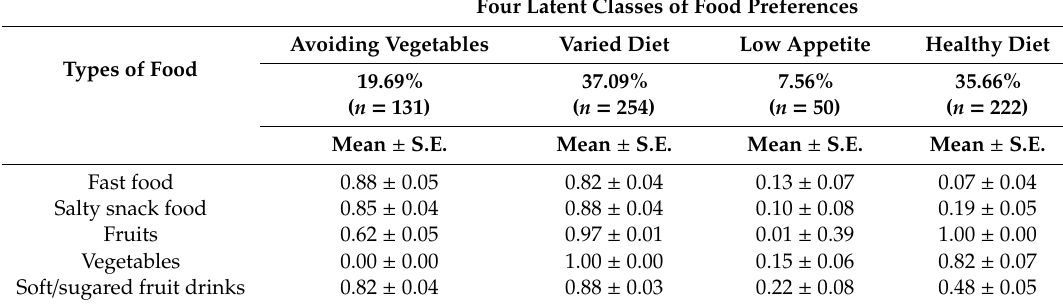
Figure 1. Description of the patterns of food preferences. x -axis = indicators of food preferences (i.e., fast food, salty snack, fruits, vegetables, soft drinks/sugared fruit drinks); y -axis = probability of a “Like” response to each food preference item conditional on latent status membership. Table 3. Item response probabilities for the four latent classes (avoiding vegetables, varied diet, low appetite, and healthy diet).